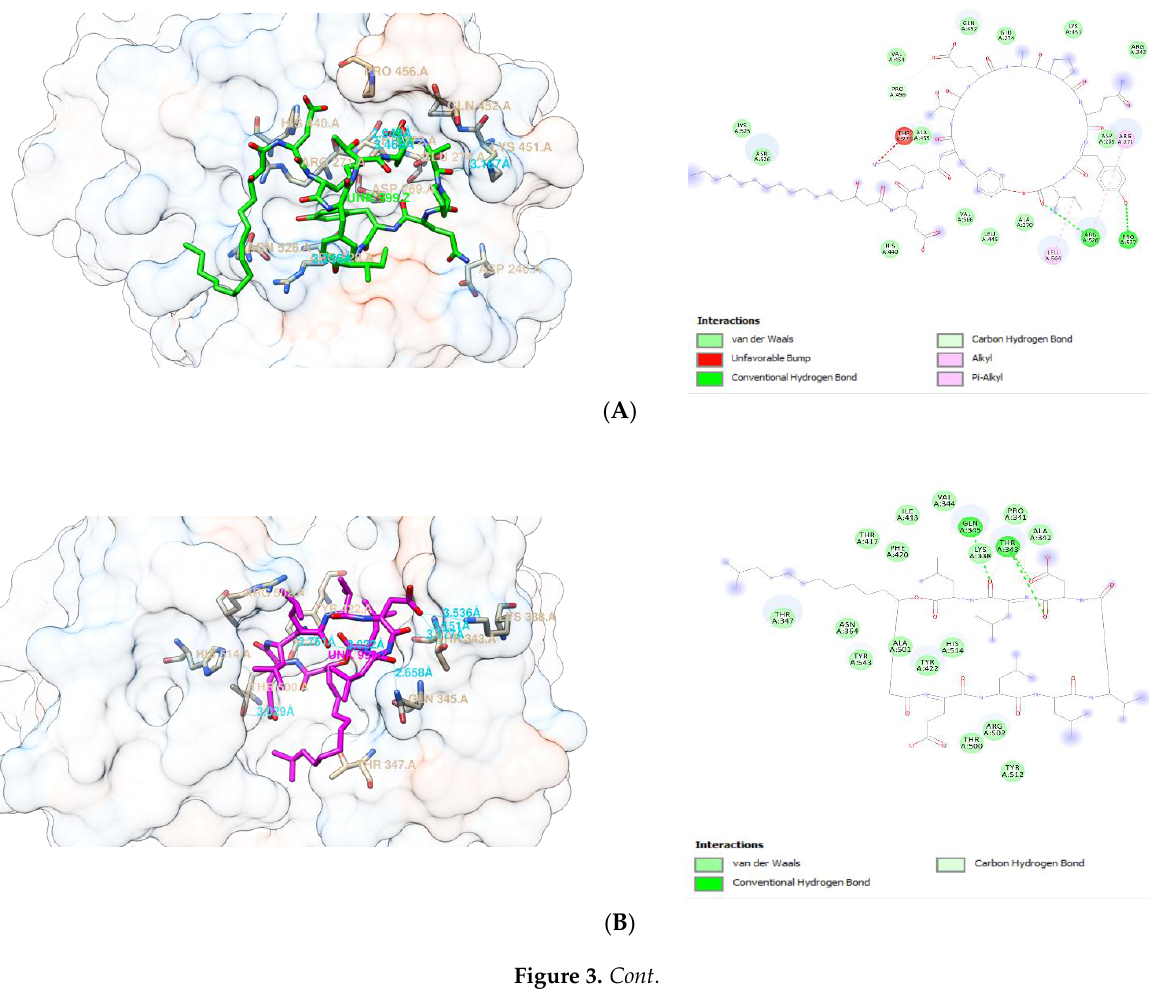
Figure 2. Molecular interaction between PBP1 with ( A ) fengycin, ( B ) surfactin, and ( C ) iturin A.